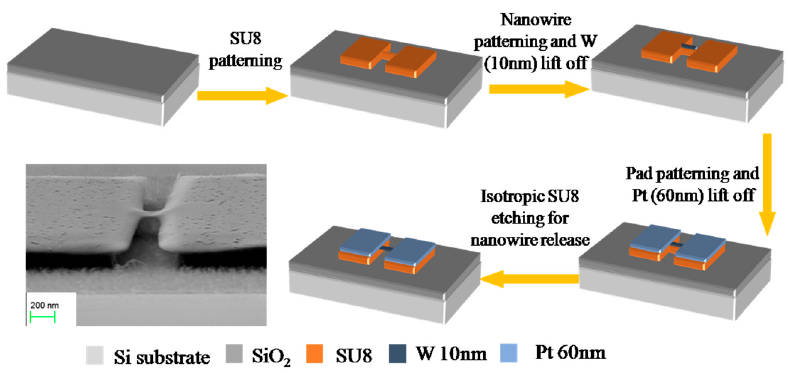
Figure 1. Fabrication flow with SEM micrograph of the final sensor device.